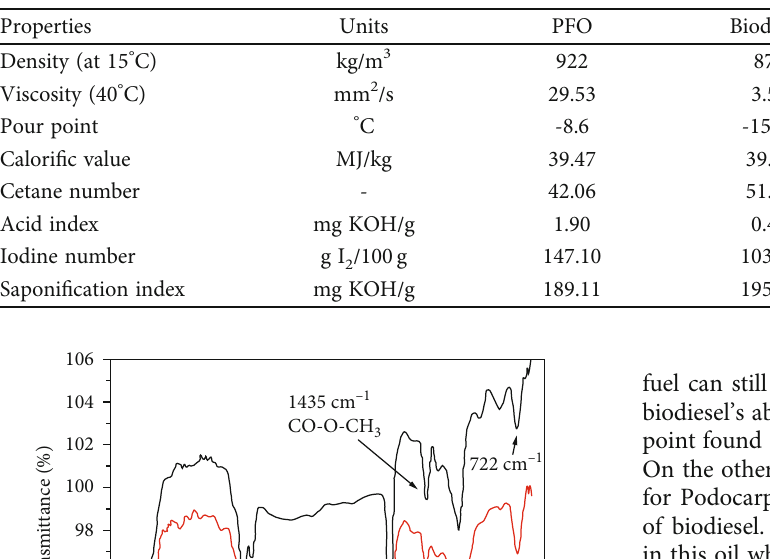
Figure 6: (a) Podocarpus falcatus oil. (b) Optimized biodiesel. Table 6: Physicochemical properties of PFO and biodiesel compared to ASTMD6751.